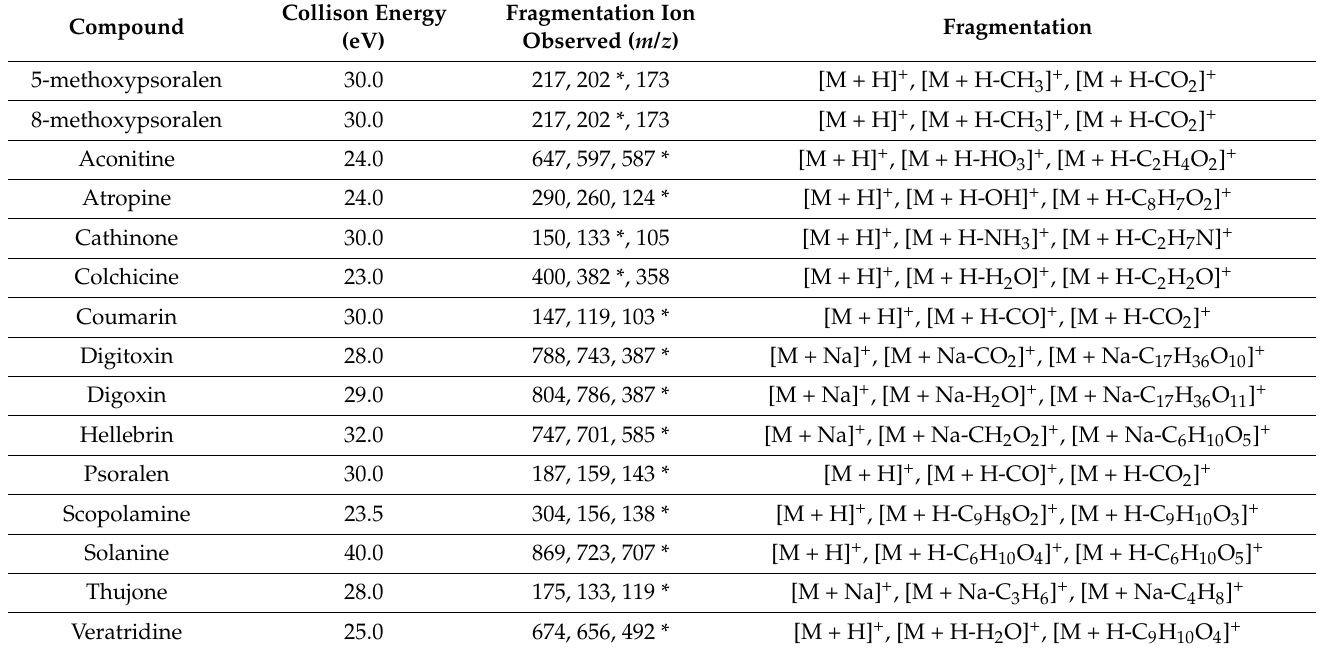
Table 2. Collison energies and fragmentation ions for